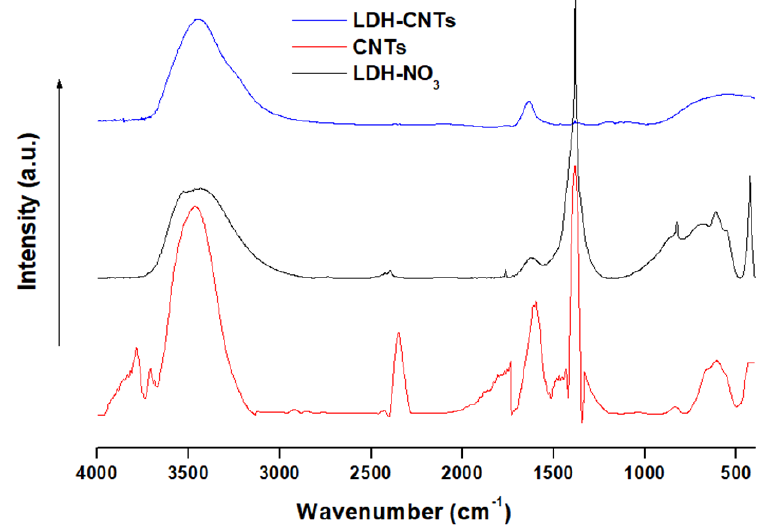
Figure 4. FTIR of LDH in nitrate form, the CNTs and the hybrid LDH-CNTs.